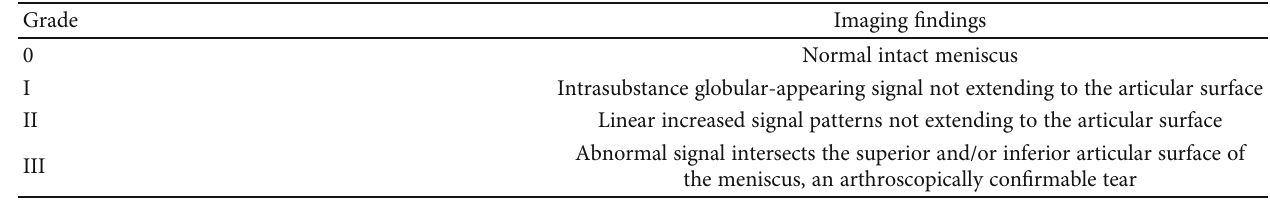
Table 1: Grading of meniscal injury.